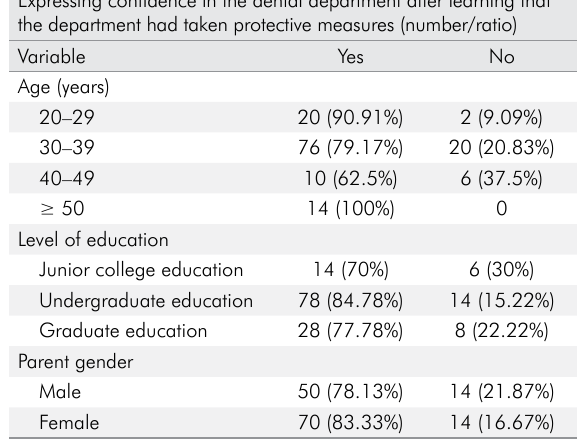
Table 5. Data on parents’ willingness to take their children to a dental department for toothache treatment (by parent age, level of education and gender).